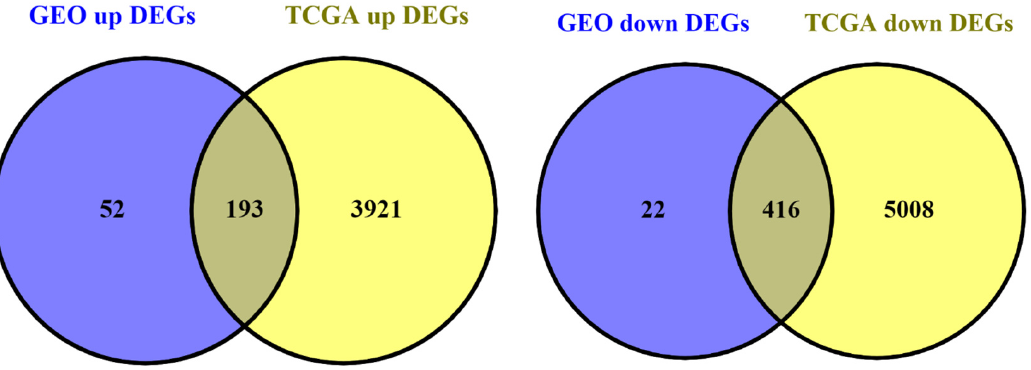
Figure 6. Venn diagram. The number of hub genes in PPI and ceRNA networks and TCGA-PRAD DEGs.